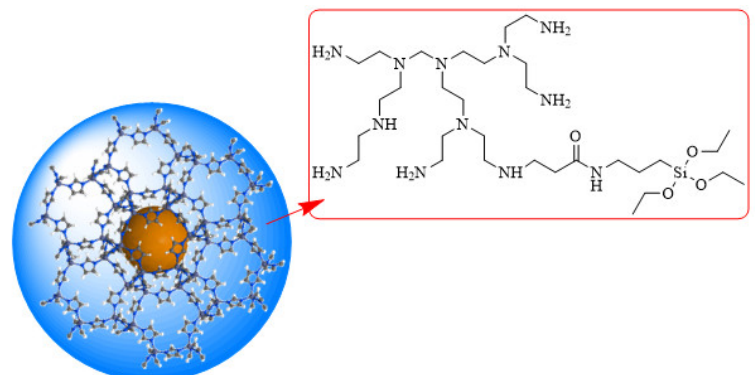
Figure 11. Schematic structure of the modified ZIF.